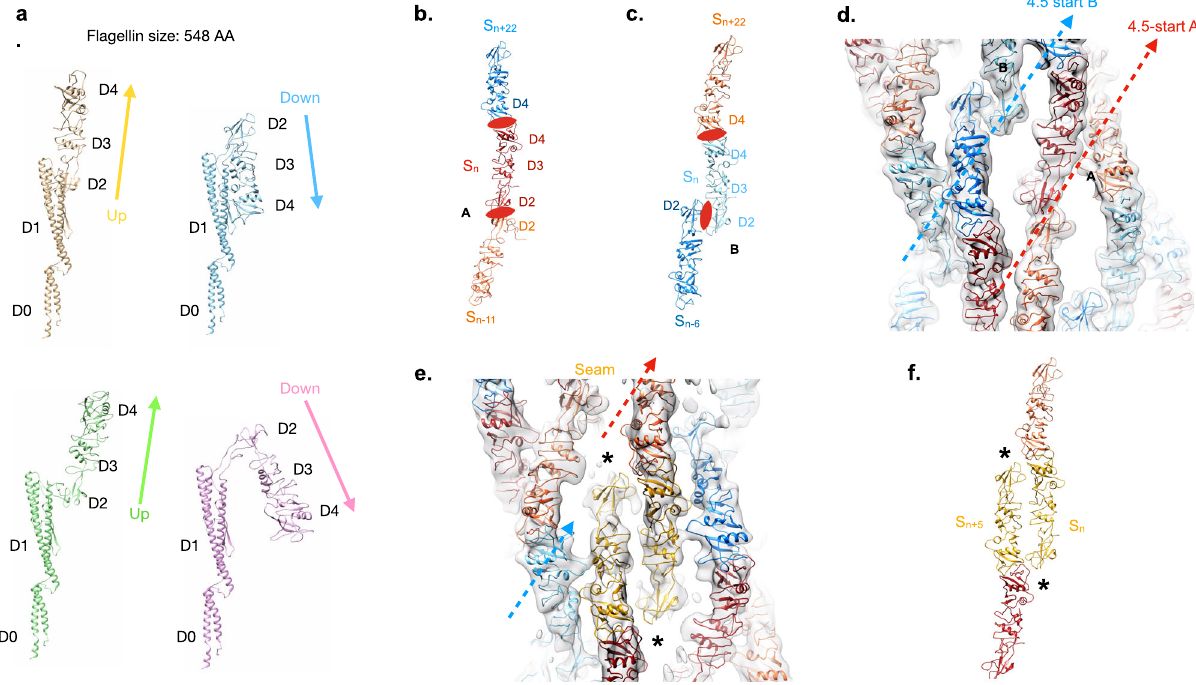
Fig. 5 Structural details of the EPEC O127:H6 fl agellar fi lament with a seam. a The four main fl agellin conformations of the EPEC H6 fl agellar fi lament. b An EPEC H6 outer domain dimer is generated by a symmetrical interaction between outer domain D2 from fl agellin S n with domain D2 of a fl agellin 11 subunits away, S n + 11 . This is named “ D2 dimer A ” . Flagellin outer domains also form a symmetrical dimer between domain D4 in subunit S n with domain D4 from a fl agellin 22 subunits away (S n + 22 ). c The second EPEC H6 outer domain dimer, “ D2 dimer B ” , is created between S n and a fl agellin six subunits away S n − 6 . d Surface view of the EPEC H6 fl agellar fi lament showing the fi t of the outer domain models into the low-resolution map. The two dimer conformations are indicated by “ A ” and “ B ” and form two right-handed 4.5-start helices. e A surface view of the EPEC H6 fl agellar fi lament, rotated by 180° around the fi lament axis from the view in ( d ), showing the seam, *, with the subunits forming the seam in gold. f Interactions between outer domain subunits (gold) along the seam. The two subunits in the seam are 5 subunits away from each other in the fi lament (S n :S n + 5 Two double mutants were constructed: N319F N323F (FF) and N319R N323R (RR) and mutant fl agellar fi laments isolated. Cryo- electron micrographs revealed that the FF mutant fi lament